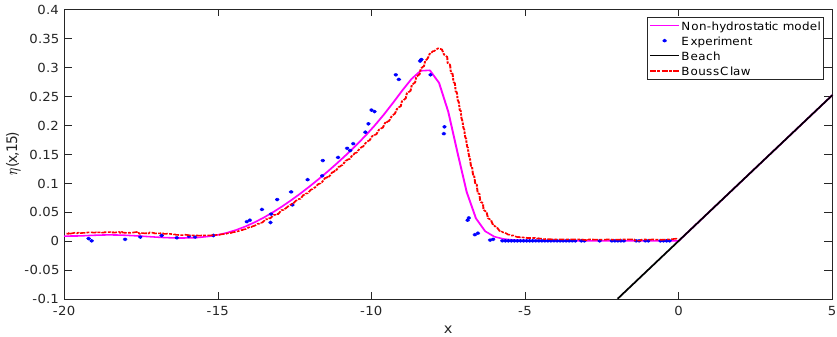
Figure 8. Wave surface profile for A / d 0 = 0.3 at t =